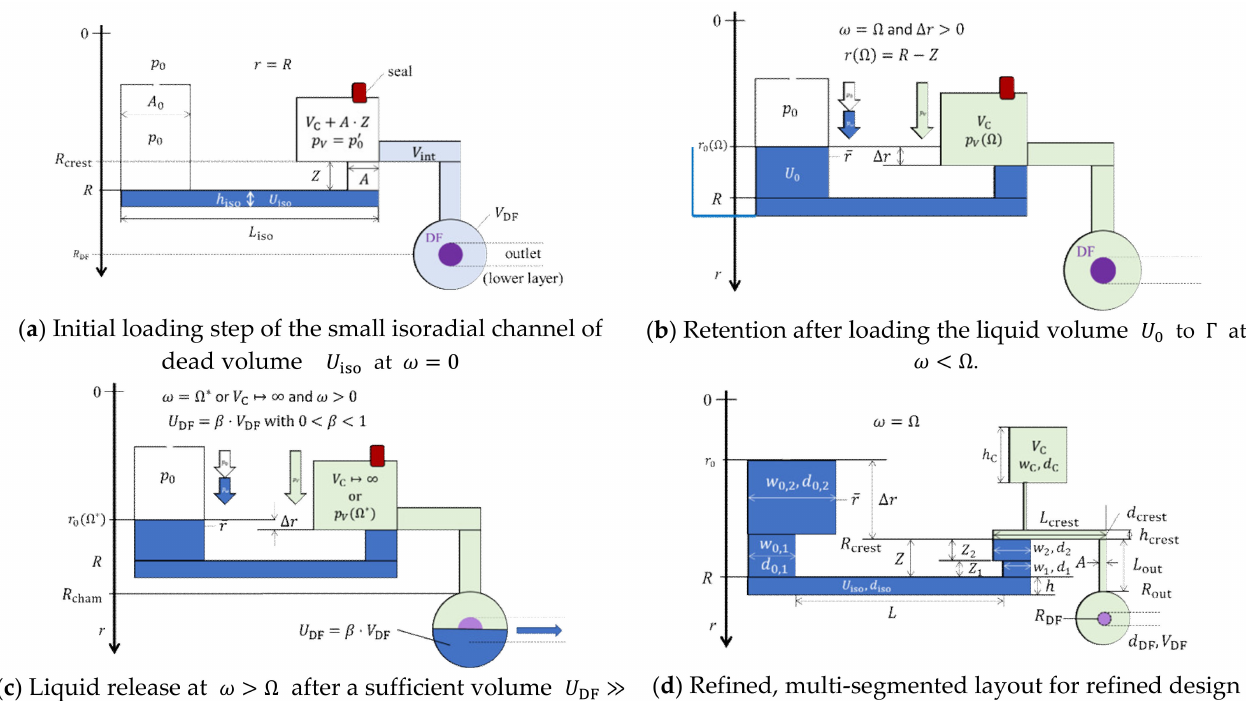
Figure 1. Centrifugo-pneumatic (CP) dissolvable-film (DF) siphon valve structure structure Γ (linearized display, dimensions not to scale with typical measures listed in the Appendix A.1). The depths d 0 = d iso = d of all components upstream of the crest point at r = R crest amount to 1 mm, and 200 µ m thereafter. ( a ) In a first step, a liquid volume U iso is loaded to the basic structure Γ which pneumatically isolates the inlet reservoir that is open to atmosphere at p 0 from the downstream compression chamber. For instance, due to dynamic effects, the actual pressure p (cid:48) in the enclosed volume can (slightly) 0 deviate from p 0 . ( b ) The liquid volume U 0 (cid:29) U iso is retained upstream of the crest point at R crest = R − Z for spin rates ω < Ω . ( c ) The high-pass CP-DF siphon valve opens for ω > Ω ∗ ≈ Ω upon arrival of a minimum volume U DF in the shallow DF chamber ( d DF (cid:28) d ). ( d ) Multi-segmented version for illustrating the key geometrical features for enhanced design optimization according to a given set of